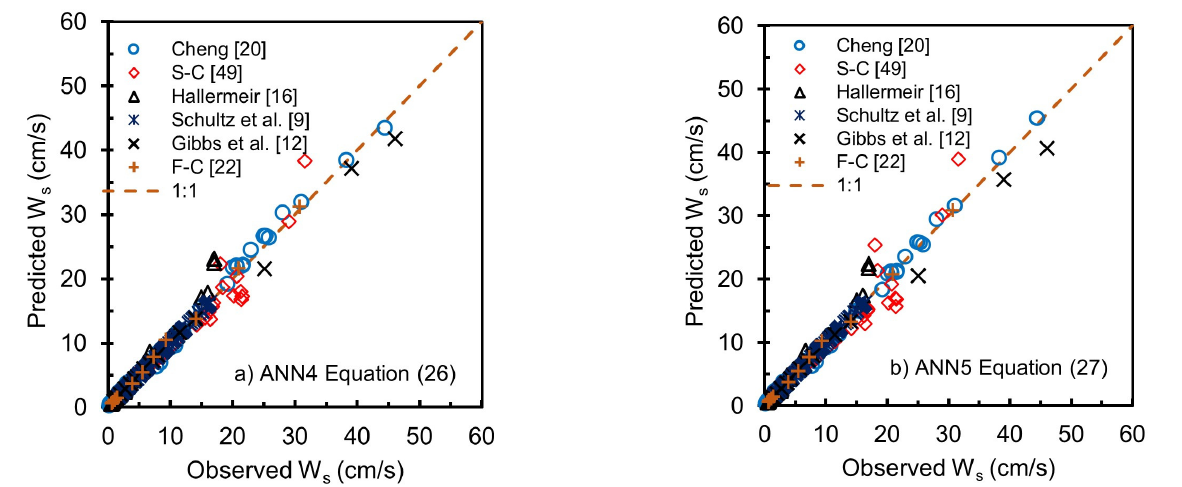
Figure 10. Scattering plot for results of testing 2 for simplified ANN4 Equation (26) ( a ) and simplified ANN5 Equation (27) ( b ).